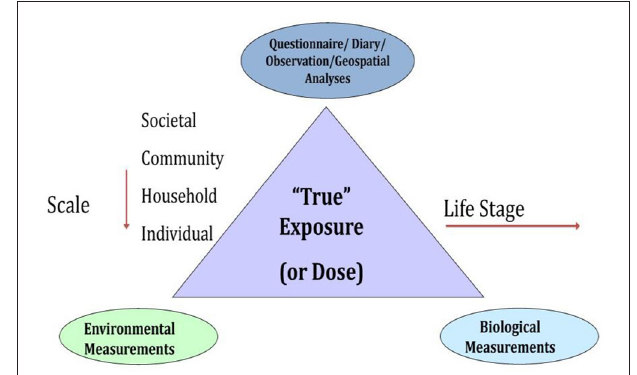
FIGURE 3 | Combined approaches for the National Children’s Study environmental exposure